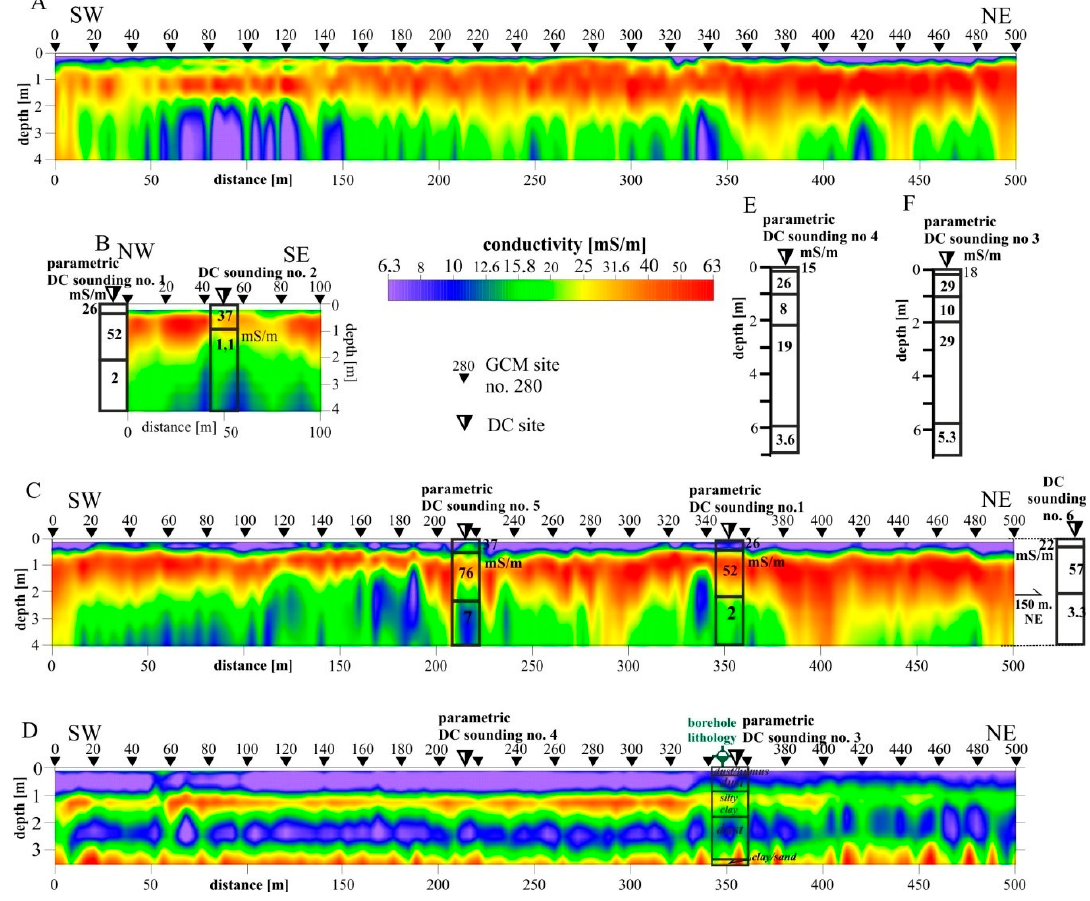
Figure 8. Conductivity depth sections from 1D Occam inversions; A —depth section of profile 0, B —depth section of profile A, C —depth section of profile 1, D —depth section of profile 2, E —result of